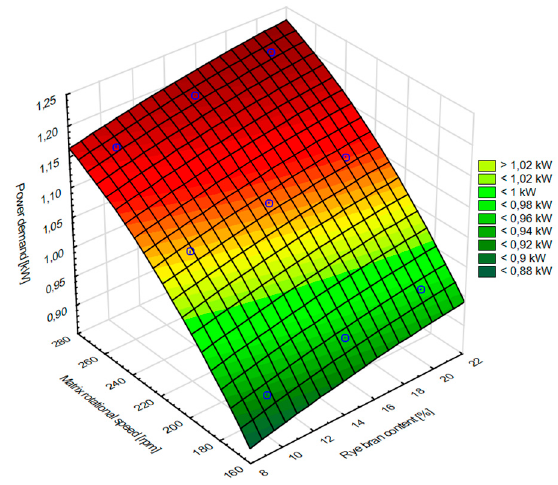
Figure 8. Influence of rye bran and rotational speed of the matrix on the granulator demand for power during the production of granulated cherry stones.